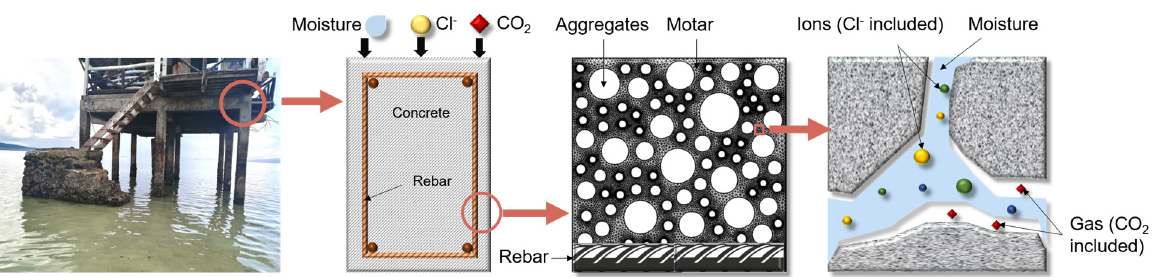
Figure 5. Schematic diagram of dual attack of chloride ingress and carbonation in unsaturated concrete. Adapted from [47].